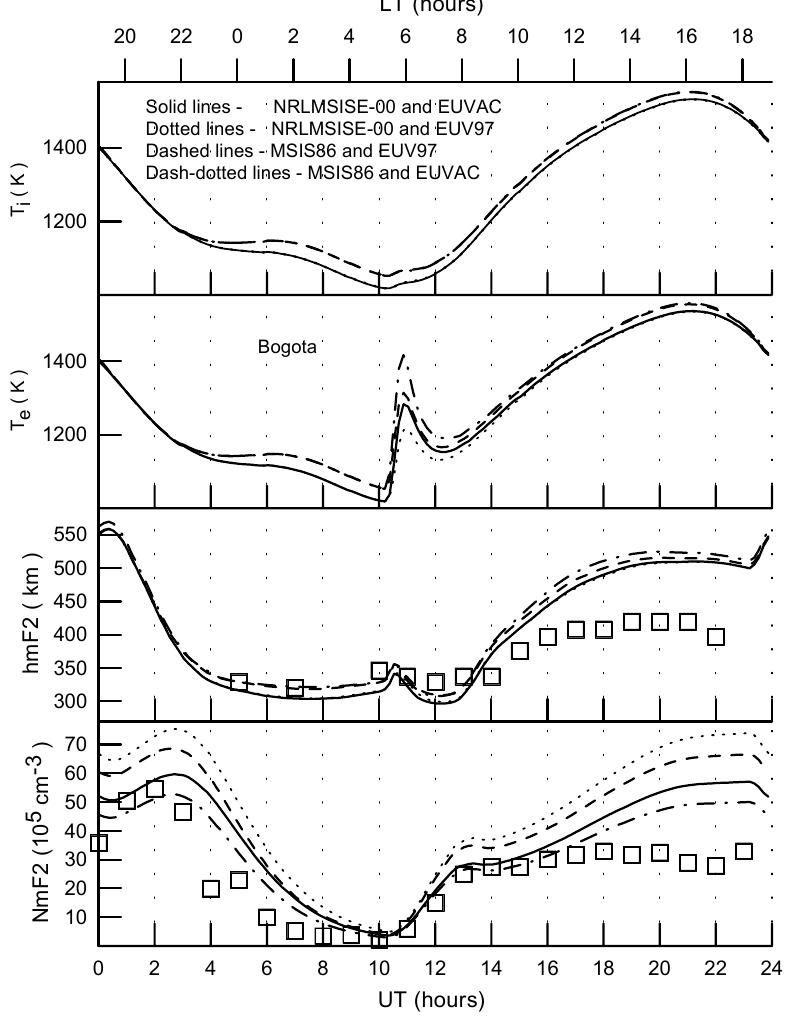
Fig. 6. From bottom to top, ob- served (squares) and calculated (lines) of Nm F2, hm F2, electron temperatures and O + ion temperatures at the F2- region main peak altitude above the Bo- gota ionosonde station on 7 October 1957. LT is the local time at the Bo- gota ionosonde station. The curves are the same as in Fig.